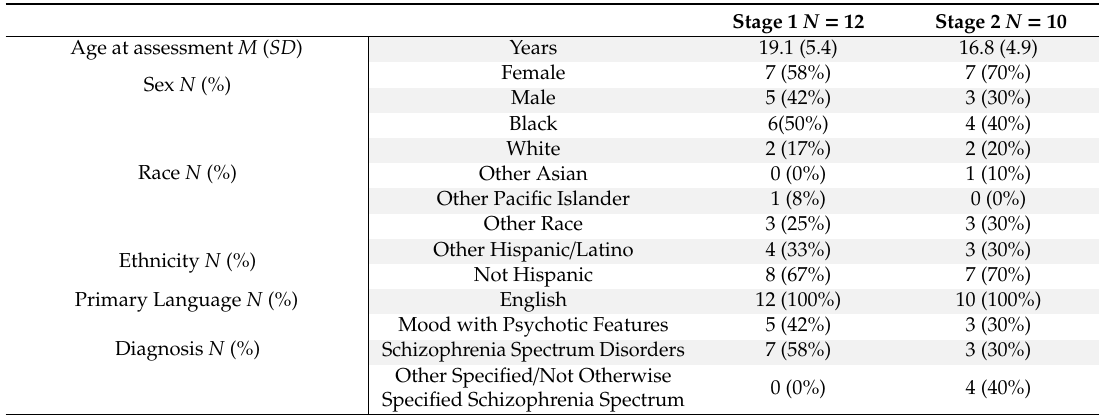
Table 1. Baseline demographic